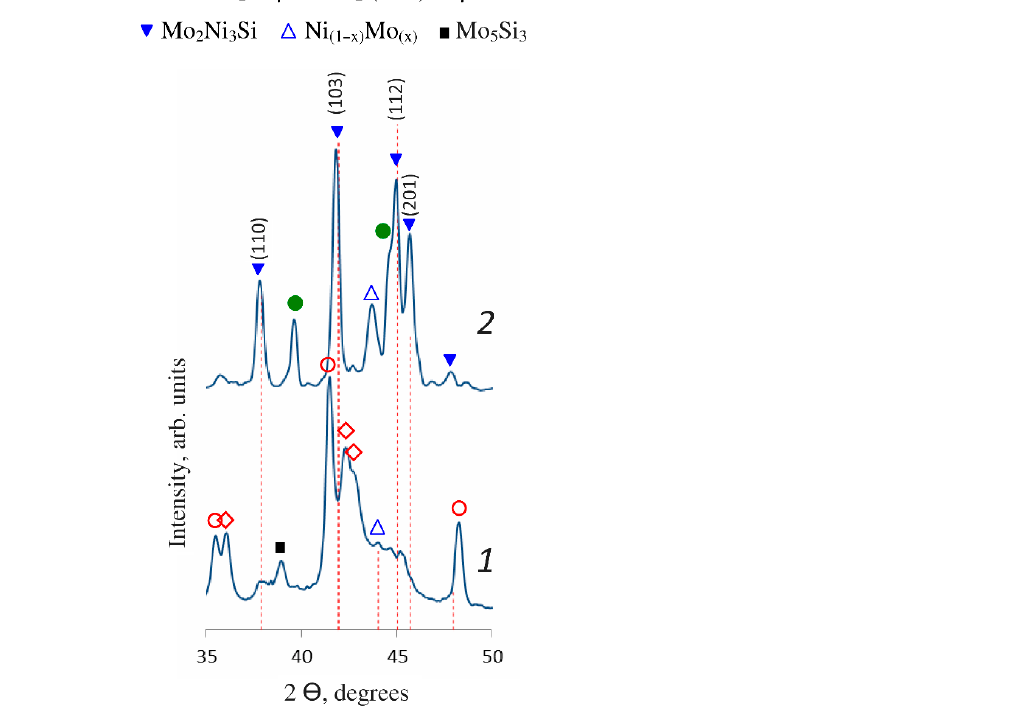
Figure 1. Regions of the XRD patterns of the coating samples deposited using the MoSi 2 -MoB-HfB 2 electrode in the as-deposited state (1) and after vacuum annealing at 900 °C (2). Dashed lines correspond to the Mo 2 Ni 3 Si phase (ICDD database, card No. 01-089-5030).